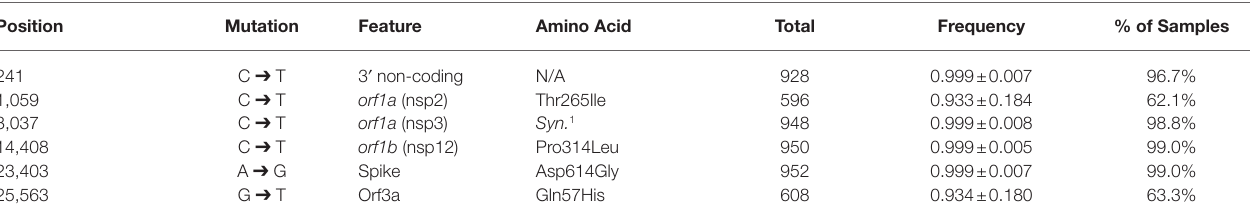
TABLE 3 | Most common consensus